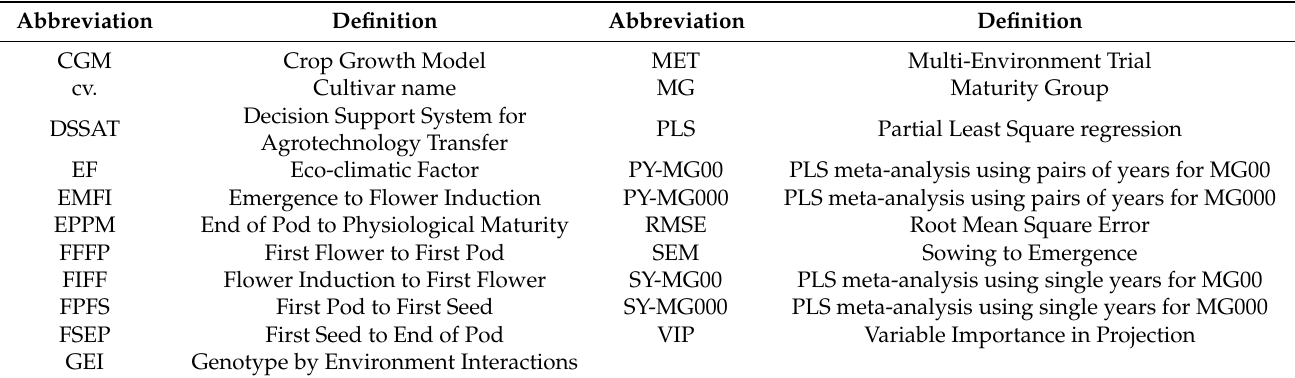
Table 1. List of abbreviation and acronyms used in the